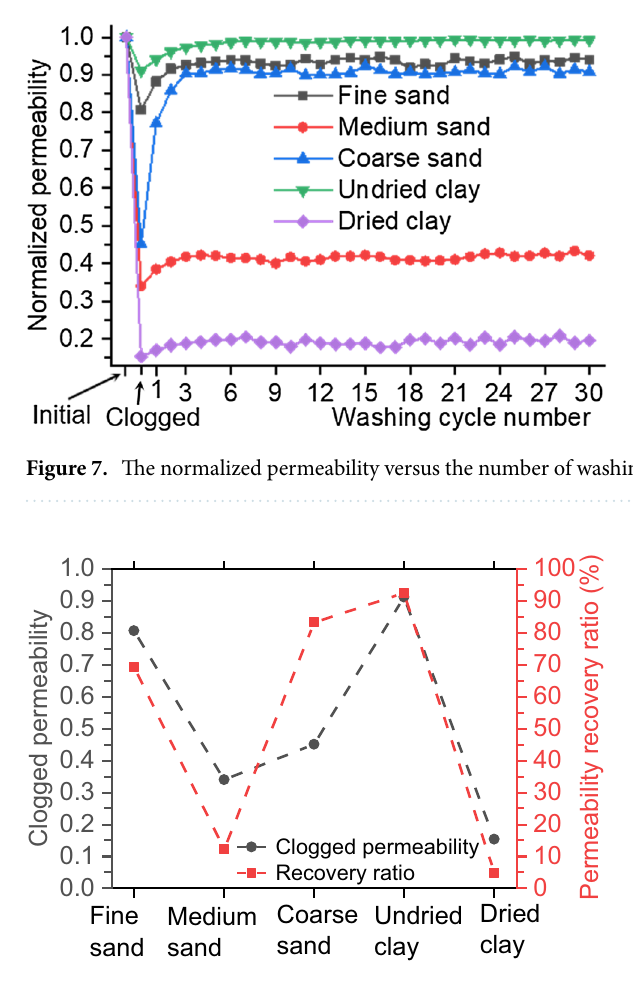
Figure 8. Clogged normalized permeability and permeability recovery ratio. The error bars represent the standard